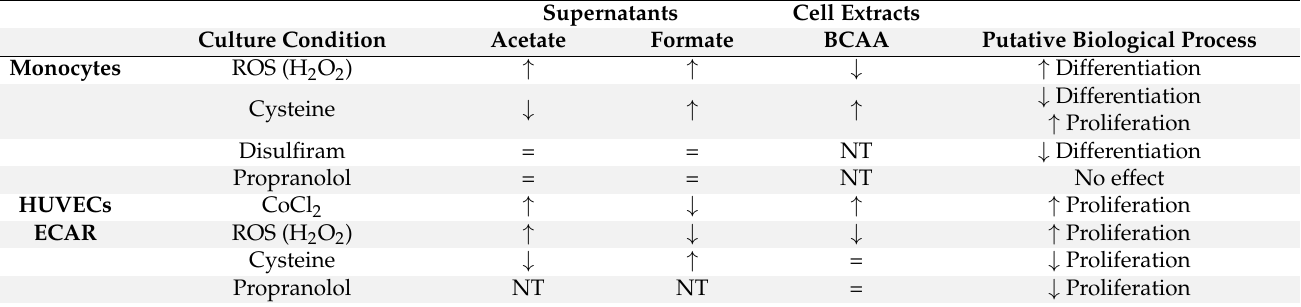
Table 1. Dynamics of acetate and formate in culture media (supernatants) and BCAAs (branched amino acids) in cell extracts of different in vitro endothelial cell models upon culture conditions related to inferred inhibition and activation of differentiation and proliferation